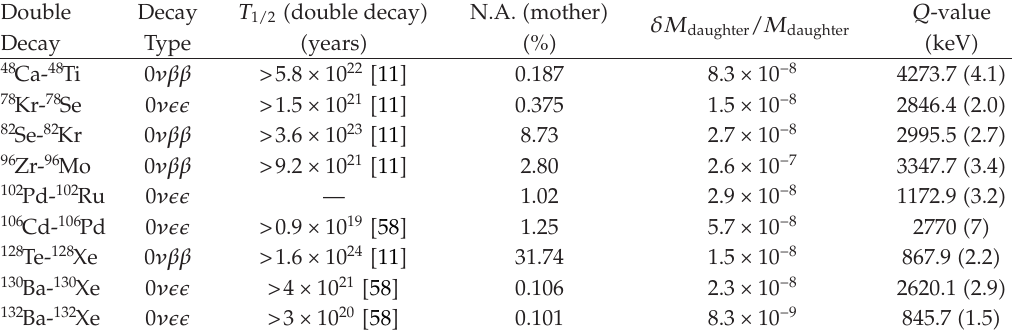
Table 2: Expected half-lives for double β -transformations from (cid:5) 58 (cid:6) . The Q -values listed in the last column have been obtained using either (cid:3) 3.3 (cid:4) or (cid:3) 3.5 (cid:4) with the mass excess values and uncertainties quoted in the latest published volume of the Atomic Mass Evaluation (cid:5) 59 (cid:6) . One can observe that the uncertainties in the Q -values are one order of magnitude larger compared to those listed in Table